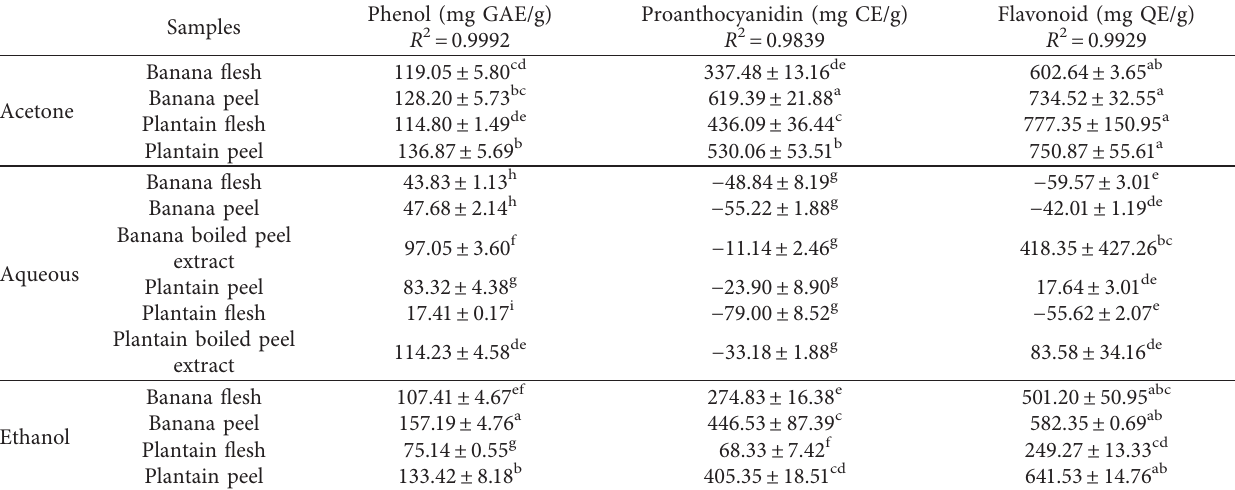
Table 2: Total polyphenolic contents of